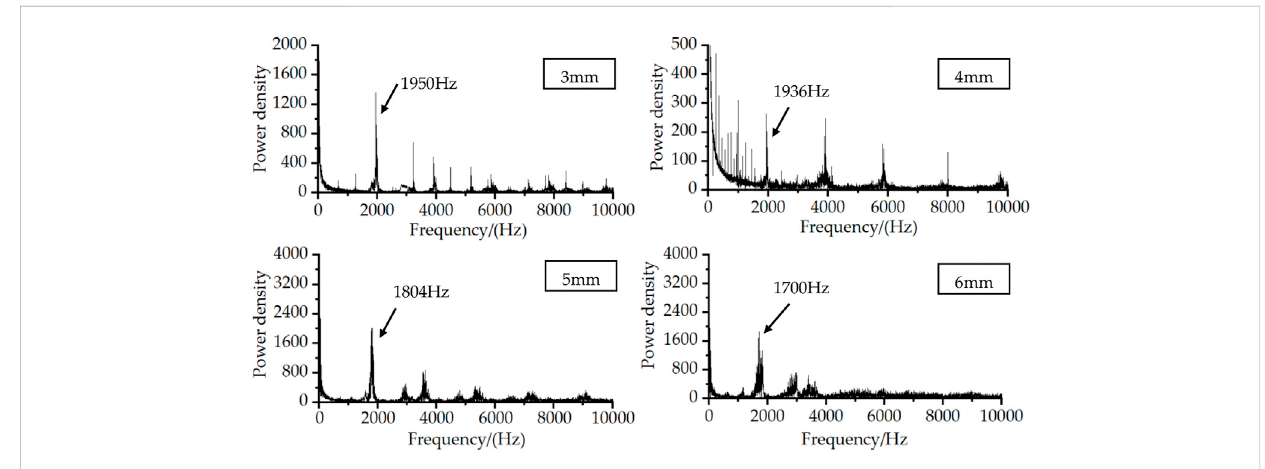
FIGURE 10 Comparison of FFT with different slot